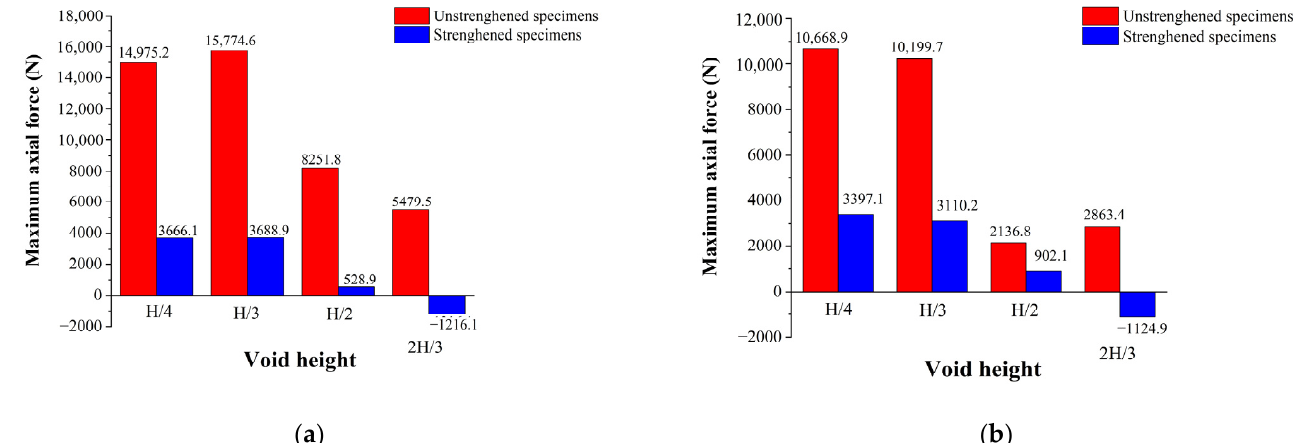
Figure 21. Maximum axial force of each specimen: ( a ) CDP and ( b )